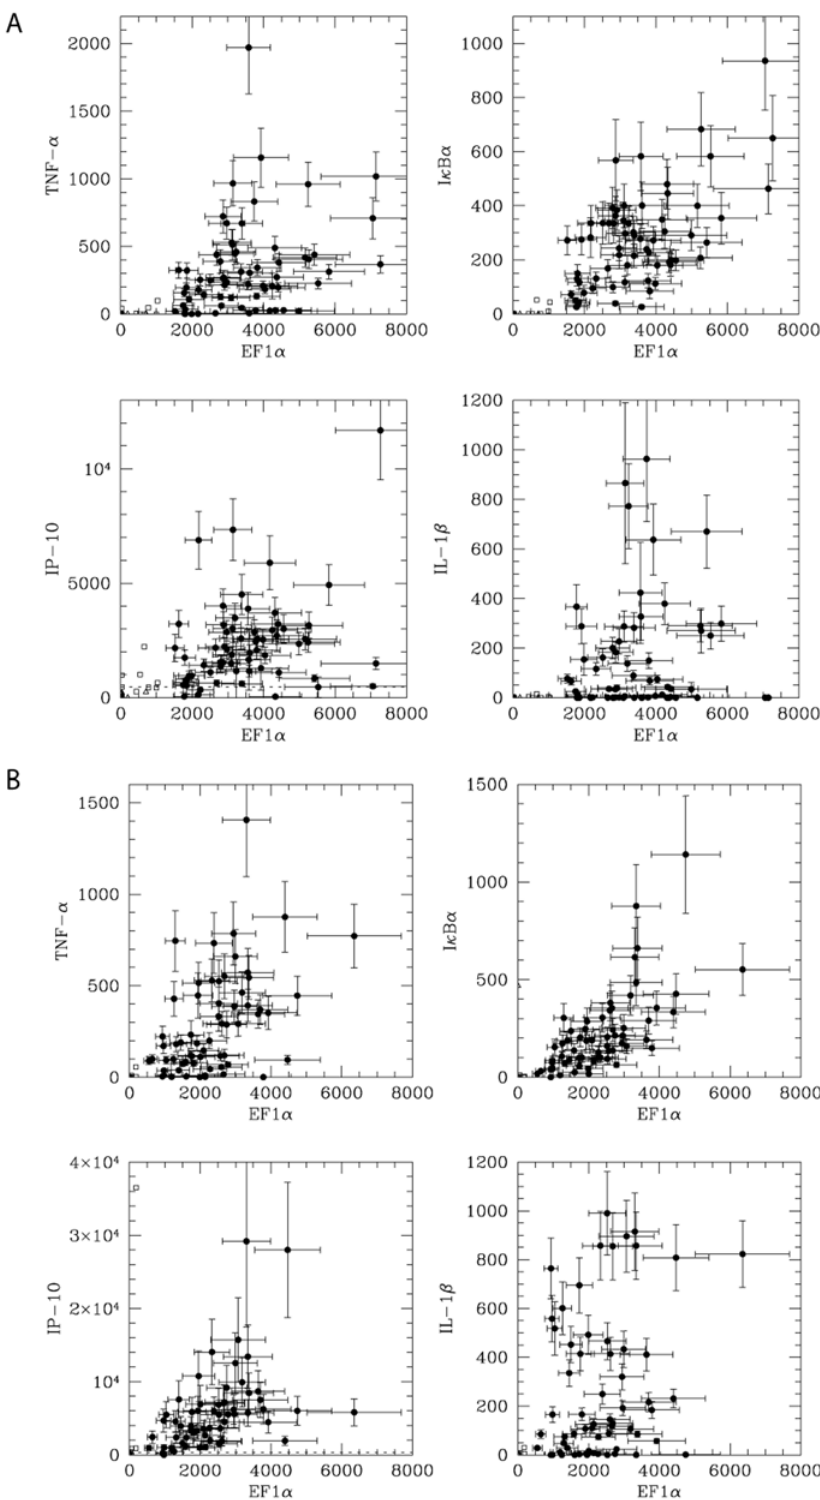
Figure 5. Simultaneous measurement of the expression of five genes in single macrophages. BMDMs were stimulated with A) poly I:C or B) LPS for 2 hours and 84 single cells (together with 12 no-cell controls) from each experiment were sorted into a microtiter plate for cDNA synthesis. mRNA standards for each gene were used to calculate absolute expression values. In each panel, the abundance of EF1 a is plotted on the X-axis, and the abundance of one of the other genes is shown on the Y-axis. This presentation permits the same cell to be identified in each panel, based on its level of expression of EF1 a (position on X-axis). Negative controls include blank wells (no cell sorted, open triangles) and misses (open squares). A missed sample is defined as having an EF1 a abundance , 2x the highest value in ‘‘blank’’ wells. The detection limit for IP-10 (taken as 2x the highest value measured in ‘‘blank’’ wells) is indicated with a dashed line.